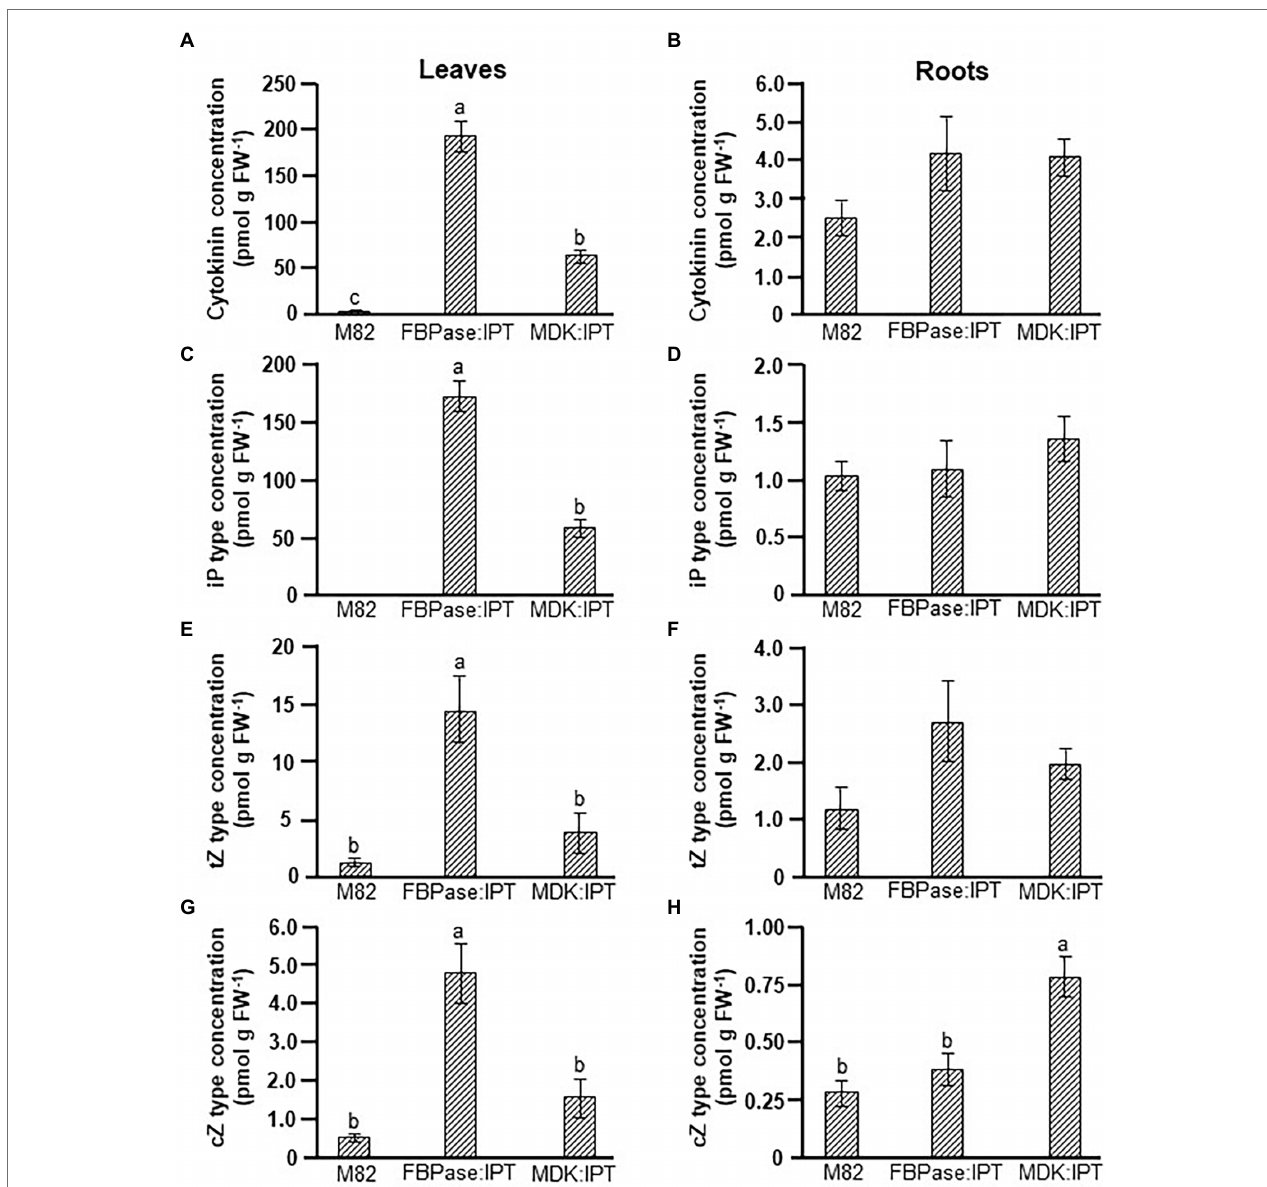
FIGURE 3 | Elevation of cytokinin concentration in tomato plants expressing IPT specifically in roots and source leaves. Total cytokinin (A,B) , iP type (C,D) , t Z type (E,F), and c Z type (G,H) concentrations in source leaves (A,C,E,G) , and roots (B,D,F,H) of control variety M82 and transgenic tomato plants expressing IPT under FBPase or AtMDK promoters (FBPase:IPT, plant line #2 and MDK:IPT, plant line #5, respectively). Plants were grown in a temperature-controlled greenhouse (25 ° C/18 ° C day/night). Data represent means (±SE) of six biological replicates. Different letters indicate significant differences between plant lines at p < 0.05 by Tukey HSD